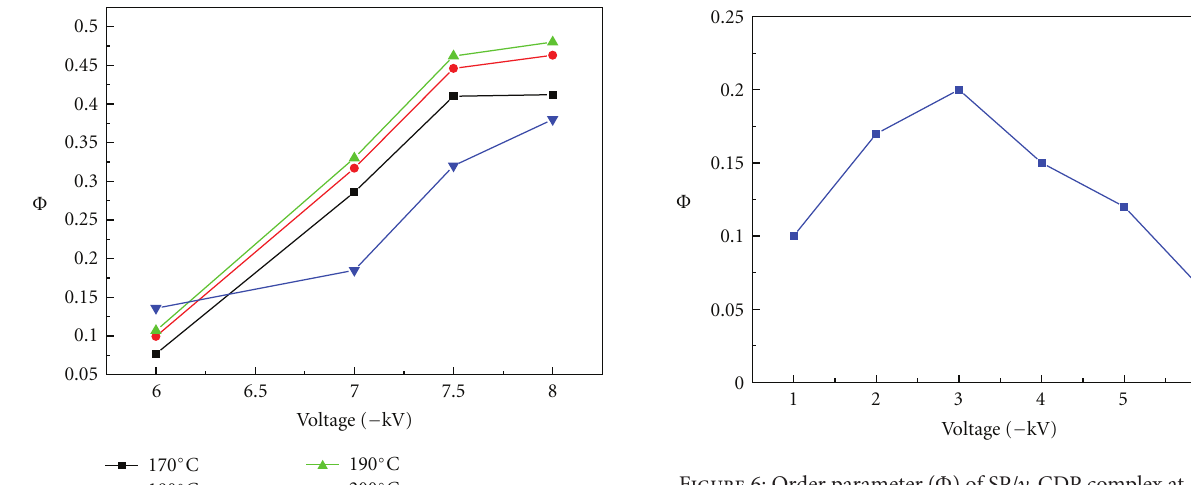
F 6: Order parameter (